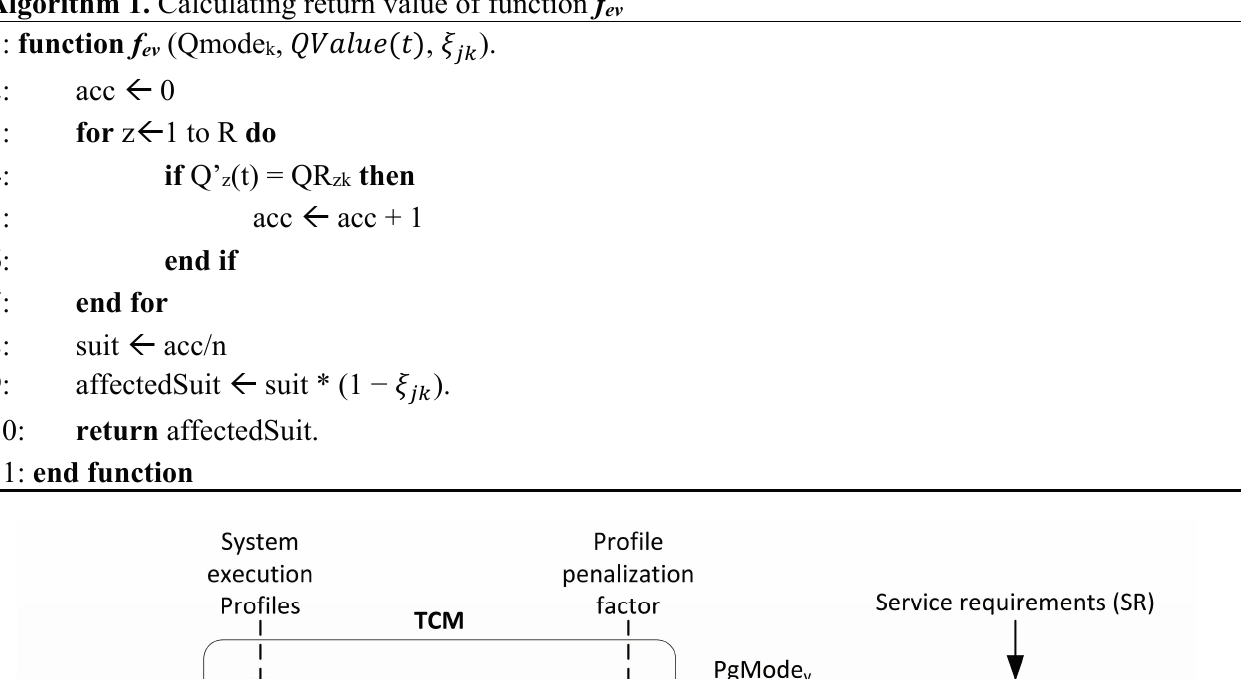
Algorithm 1. Calculating return value of function f